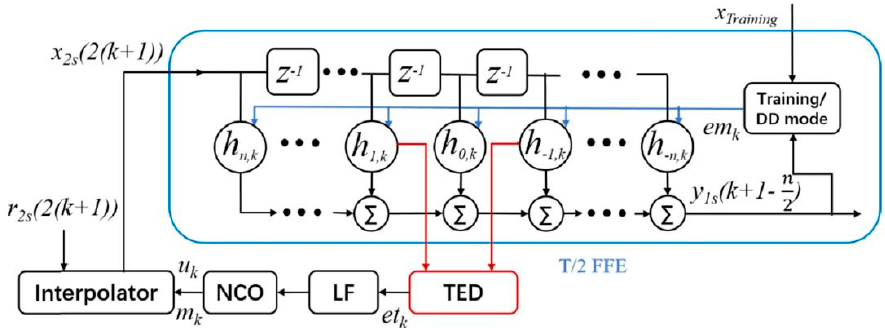
Figure 13. The structure of proposed joint clock recovery and FFE (CR-FFE) (reprinted from [39] with open access from OSA).